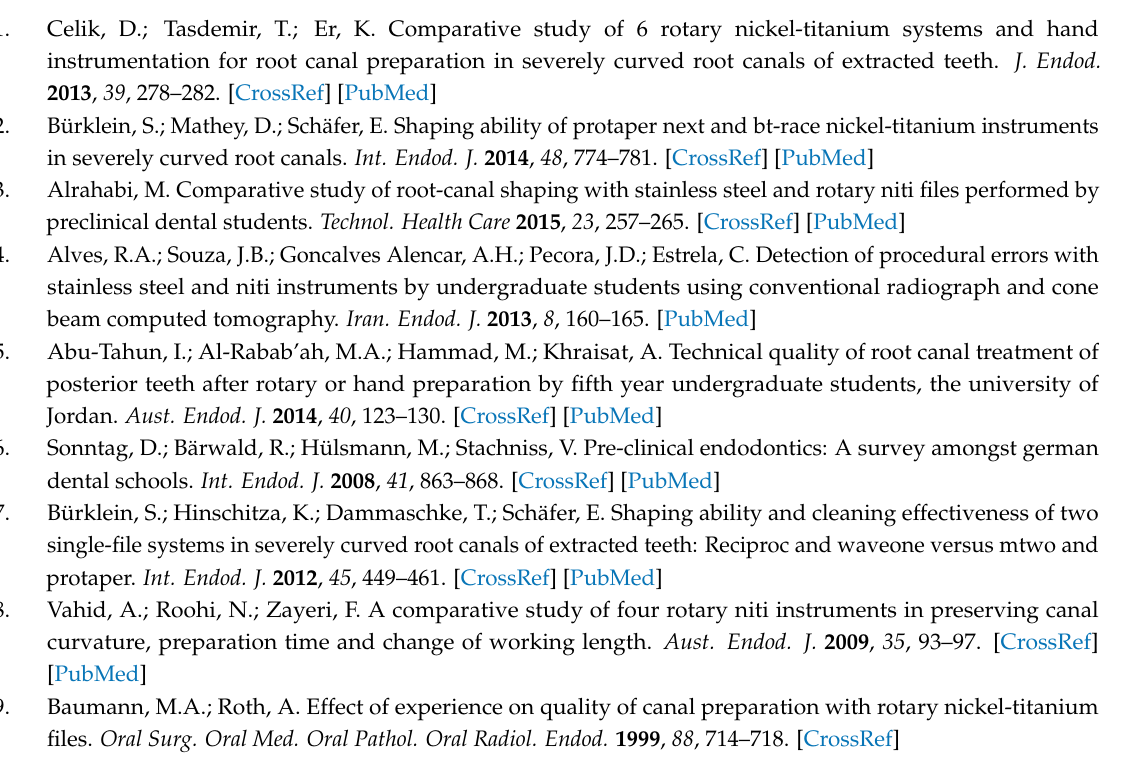
Table S1: Detailed information of the instruments and materials used in this study, Questionnaire S2: Study questionnaire for the students’ evaluation of the different root canal preparation